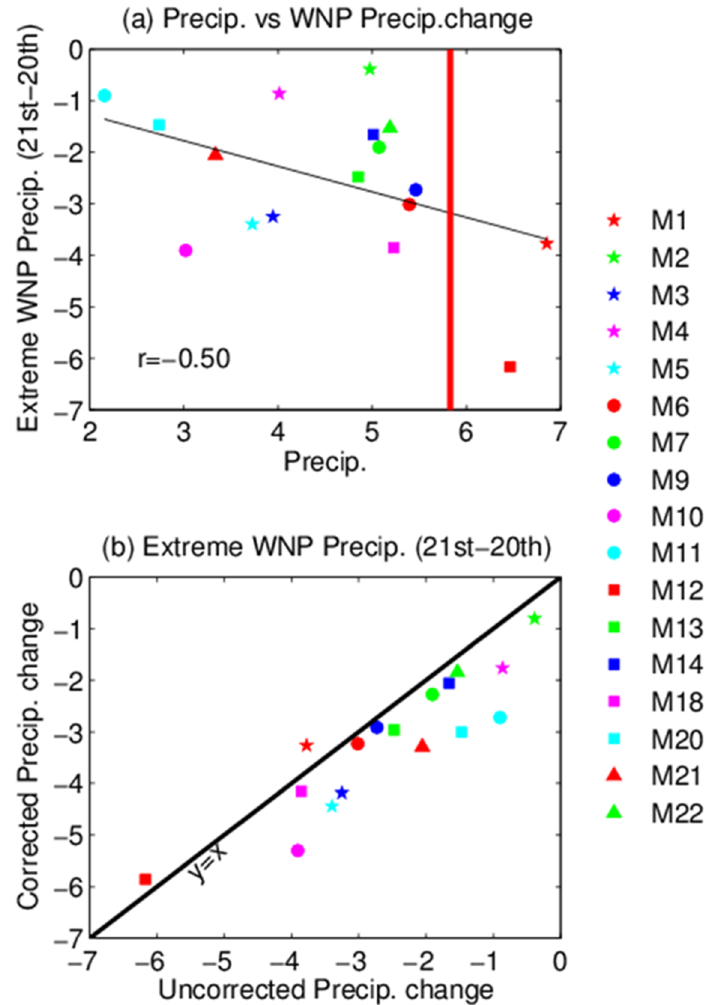
Figure 13. ( a ) Inter-model relationship between the projected changes in the WNP precipitation anomalies caused by extreme El Niño events and simulated present-day equatorial western Pacific precipitation (mm/day). The red line in ( a ) displays the observed equatorial western Pacific precipitation. ( b ) Uncorrected versus corrected changes in the WNP precipitation anomalies caused by extreme El Niño events under the RCP 8.5 scenario in CMIP5 CGCMs.